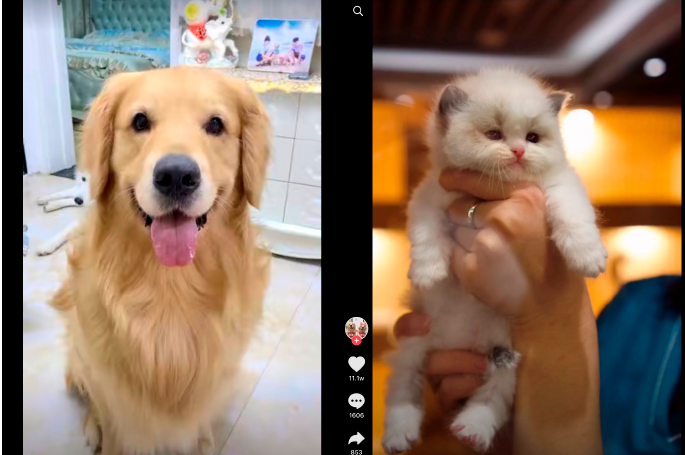
Figure 1. Examples of pet video and pet live streaming.